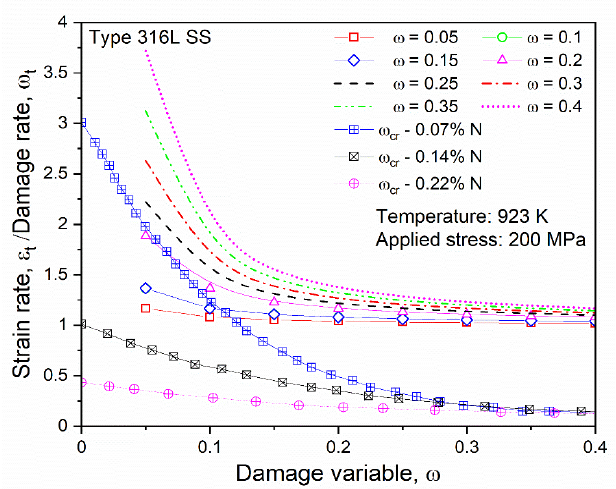
Figure 9. Comparison of the variations in the ratio between the strain rate and the damage rate for the simulation and the experiment [45].